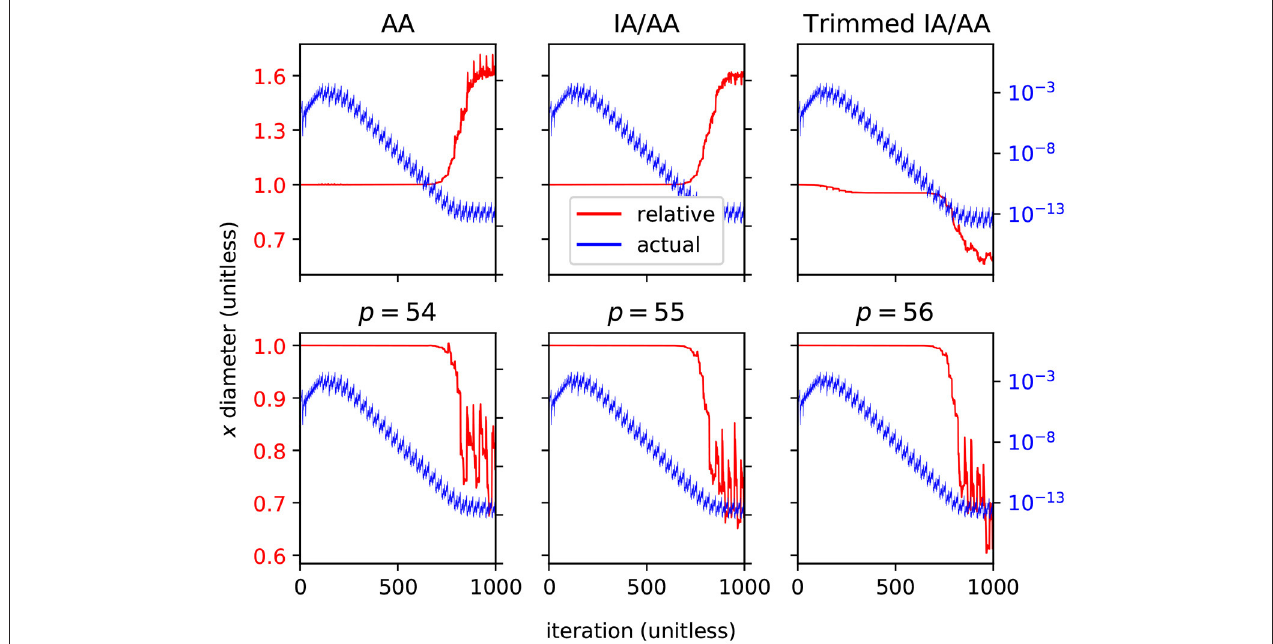
FIGURE 3 | Relative diameters (red, linear scale) and actual diameters (blue, log scale) of Arpra ranges representing the Hénon map’s x variable. The top plots show diameters of Arpra ranges computed with the AA, mixed IA/AA and mixed trimmed IA/AA methods, where relative diameter plots are relative to INTLAB mixed IA/AA range diameters. The bottom plots show diameters of Arpra mixed trimmed IA/AA ranges computed with internal precision set to p relative diameter plots are relative to Arpra range diameters with internal precision set to p